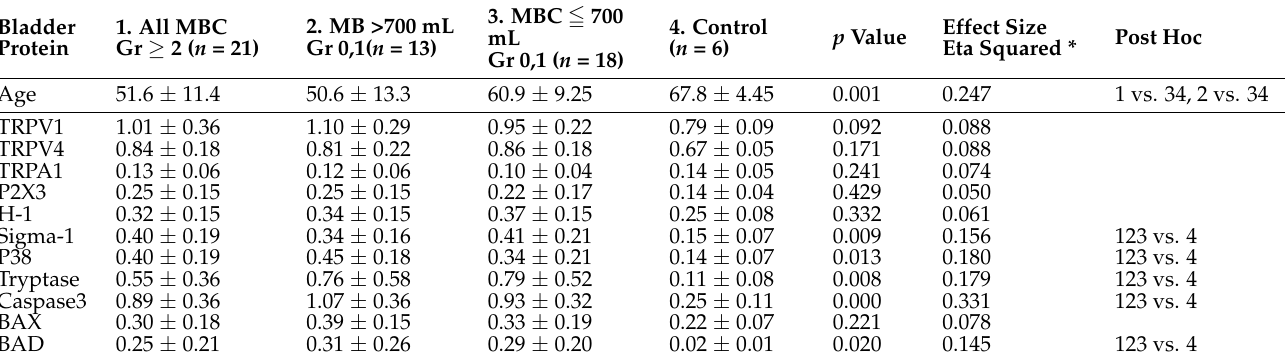
Table 7. Sensory, inflammatory, and pro-apoptotic protein expression levels in the urothelium of patients with interstitial cystitis/bladder pain syndrome with different bladder conditions during hydrodistention and